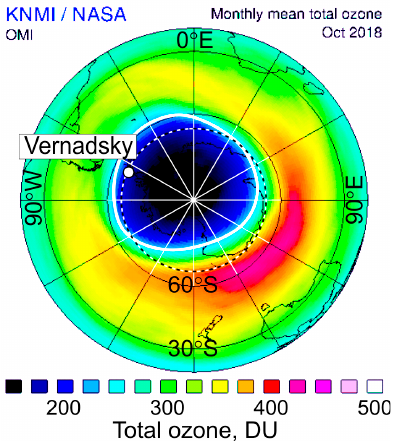
Figure 1. Total ozone monthly mean in October 2018 over southern polar region. White contour outlines the ozone hole edge at the 220-DU total ozone level. The Antarctic station Faraday / Vernadsky is shown by the white circle, modified from [55].